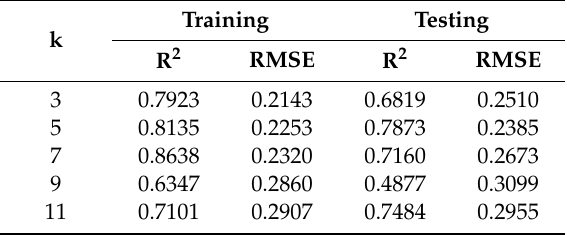
Table 13. Statistical results of drying kinetics of persimmon for kNN model using HAD method. Training Testing k R 2 RMSE R 2